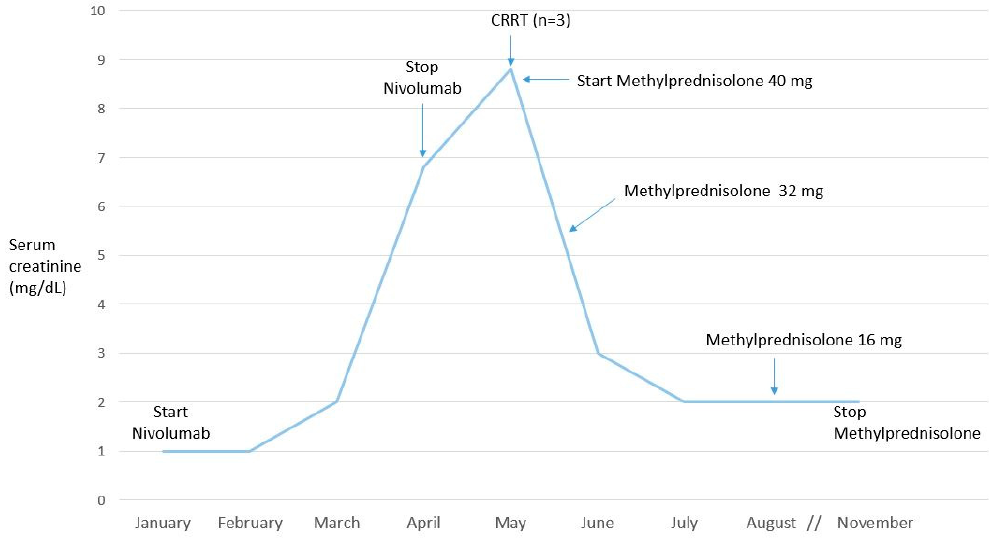
Figure 3. Time course of renal function over time.